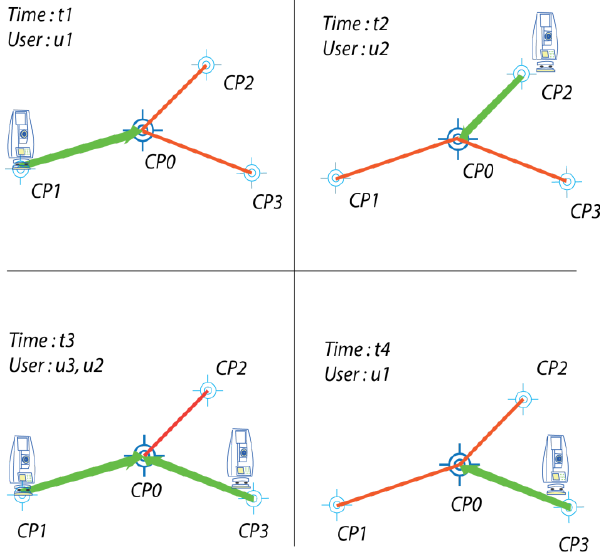
Figure 5: Multi user / time position control point